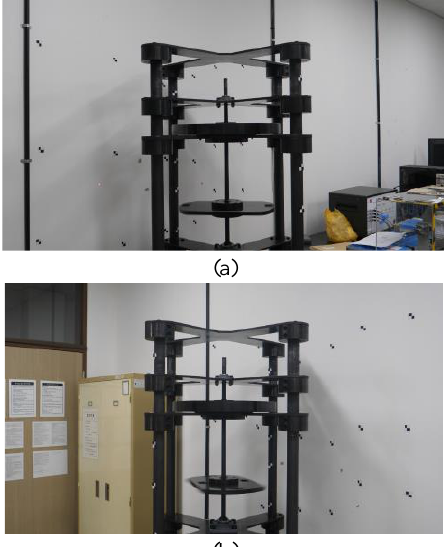
Figure 2. A frame from the videos recorded by two cameras, (a) Camera A, and (b) Camera B